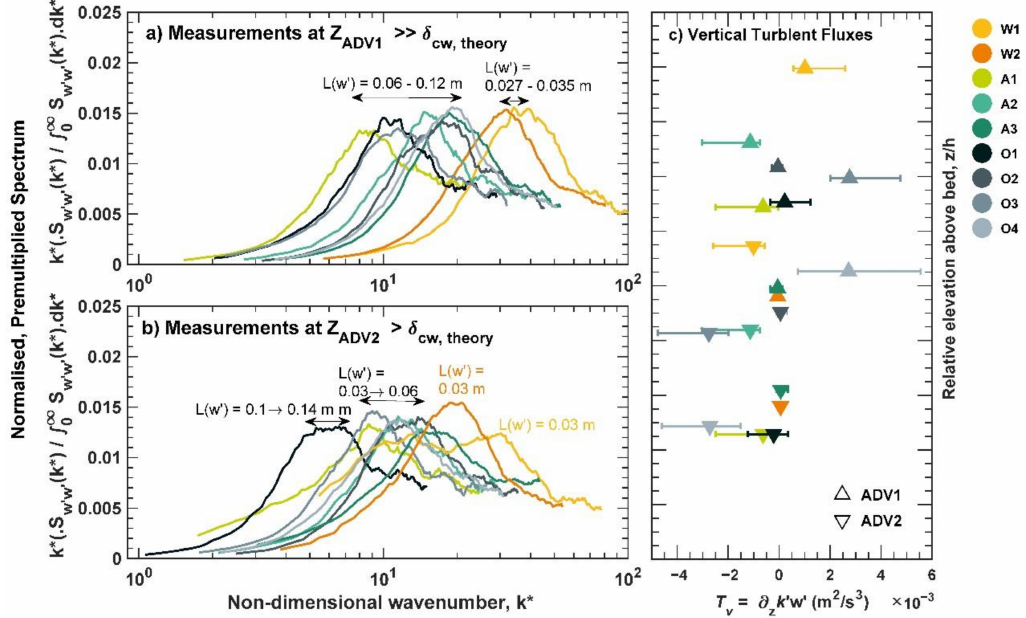
Figure 6. Non-dimensional, pre-multiplied wave number spectra of vertical fluctuations (w (cid:48) ), normalised in an energy preserving form (equal area under the curve represents equal energy) for ( a ) measurements at the higher ADV1 elevation; and ( b ) measurements at the lower ADV2 elevation. ( c ) Rate of vertical turbulent transport (turbulent kinetic energy flux in the vertical), T v